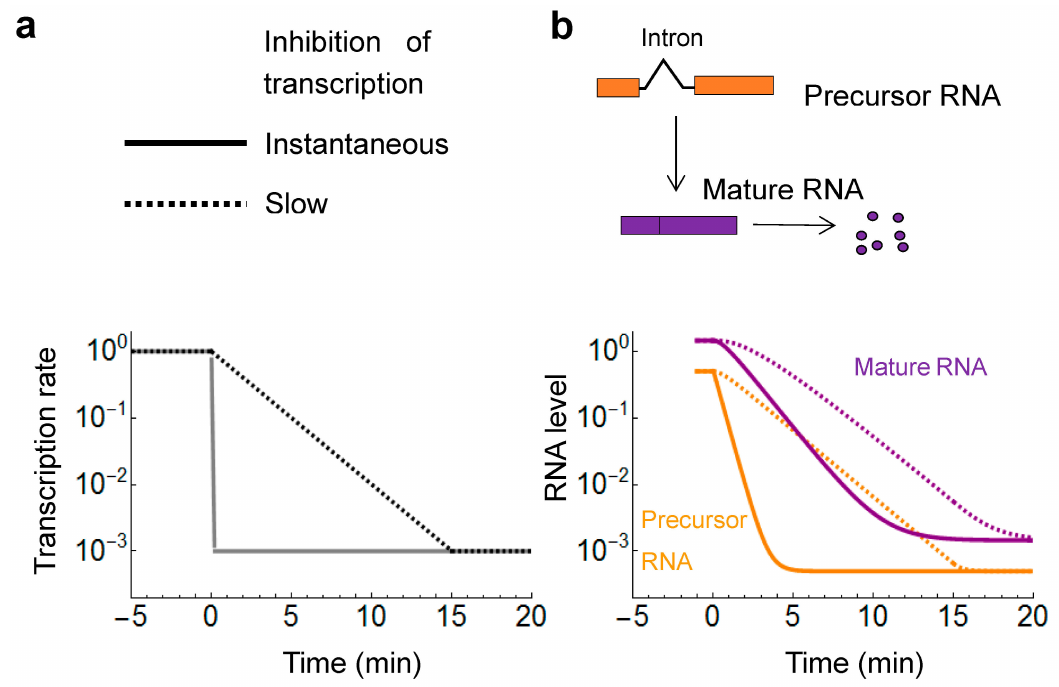
Figure 2. Impact of the speed of transcriptional inhibition on the measured mRNA half-lives. ( a ) Two different scenarios are shown for the inhibition of transcription. In the ideal case, the inhibition occurs instantaneously down to a baseline level (full line). In suboptimal cases, inhibition of transcription ensues with slow kinetics (dashed line); ( b ) The decay of RNA upon instantaneous (full lines) and slow (dashed lines) inhibition of transcription. The precursor mRNA (orange), containing the intron, can be used to monitor the inhibition kinetics since the precursor is converted rapidly to mature mRNA (purple) by splicing. The half-life of the mature mRNA (purple) will appear much longer with the slow inhibition kinetics and there is also a longer lag period before the mRNA level starts to